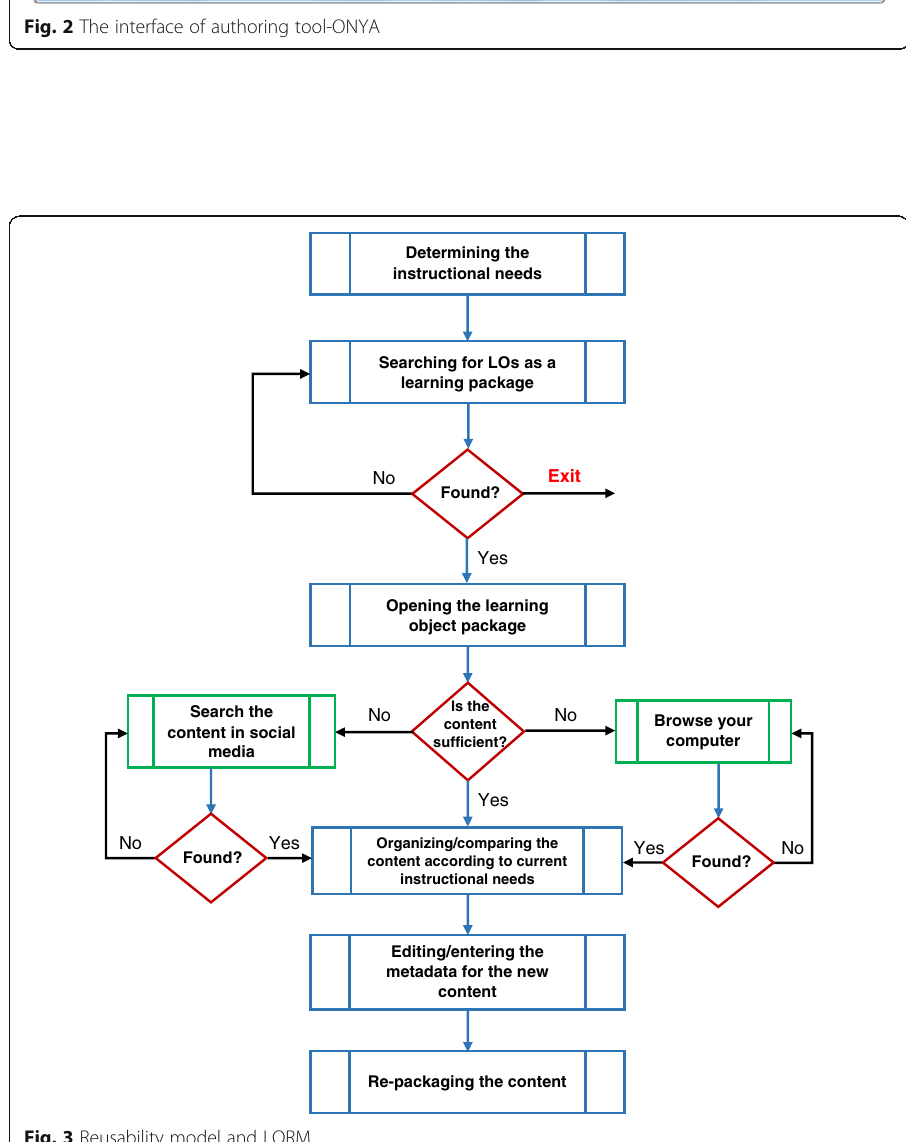
Fig. 3 Reusability model and